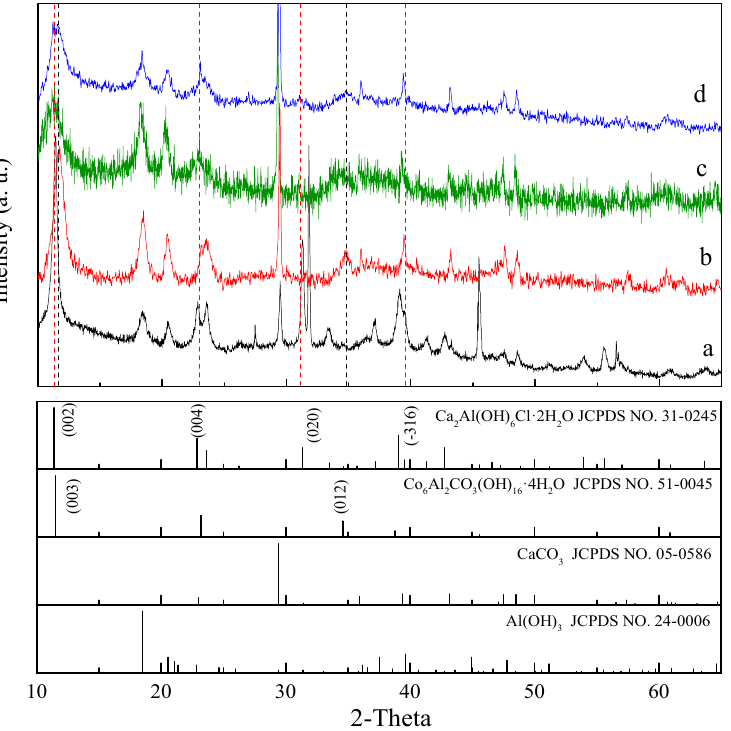
Figure 1. X-ray diffraction (XRD) patterns of original layered double hydroxides (LDHs) and Co-adsorbed LDHs at different pH values. (a) CaAl-Cl-LDHs; (b) Co-LDH at pH = 3; (c) Co-LDH at pH = 6; (d) Co-LDH at pH = 12.